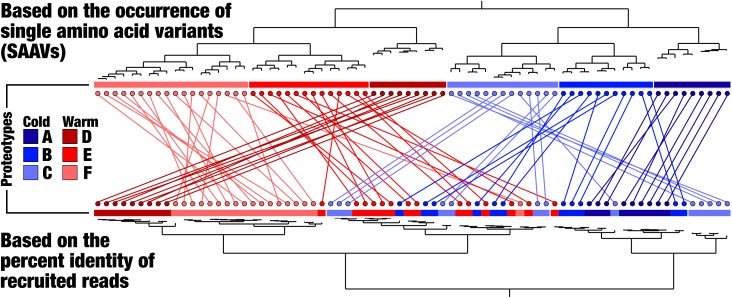
A comparison of dendrograms that organize metagenomes based on the genomic variability observed in the core 1a.3.V genes. Above, the metagenomes are organized by applying a novel graph-based activity regularization technique for competitive learning from hyper-dimensional data to the 738,324 SAAVs (see Materials and methods). Below, the metagenomes are organized by a less comprehensive approach in which the percent identity distributions are hierarchically clustered via Euclidean distance. The first method therefore is sensitive to the identity and positions of amino acid variability, whereas the second method is based solely on a summary statistic that quantifies the degree of sequence divergence at the DNA level and is agnostic to position and identity. Each metagenome is connected to itself through a straight line and is colored according to the proteotype to which it belongs.